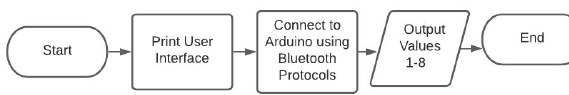
Figure 5: Flow chart of the Android application installed in the smartphone for control